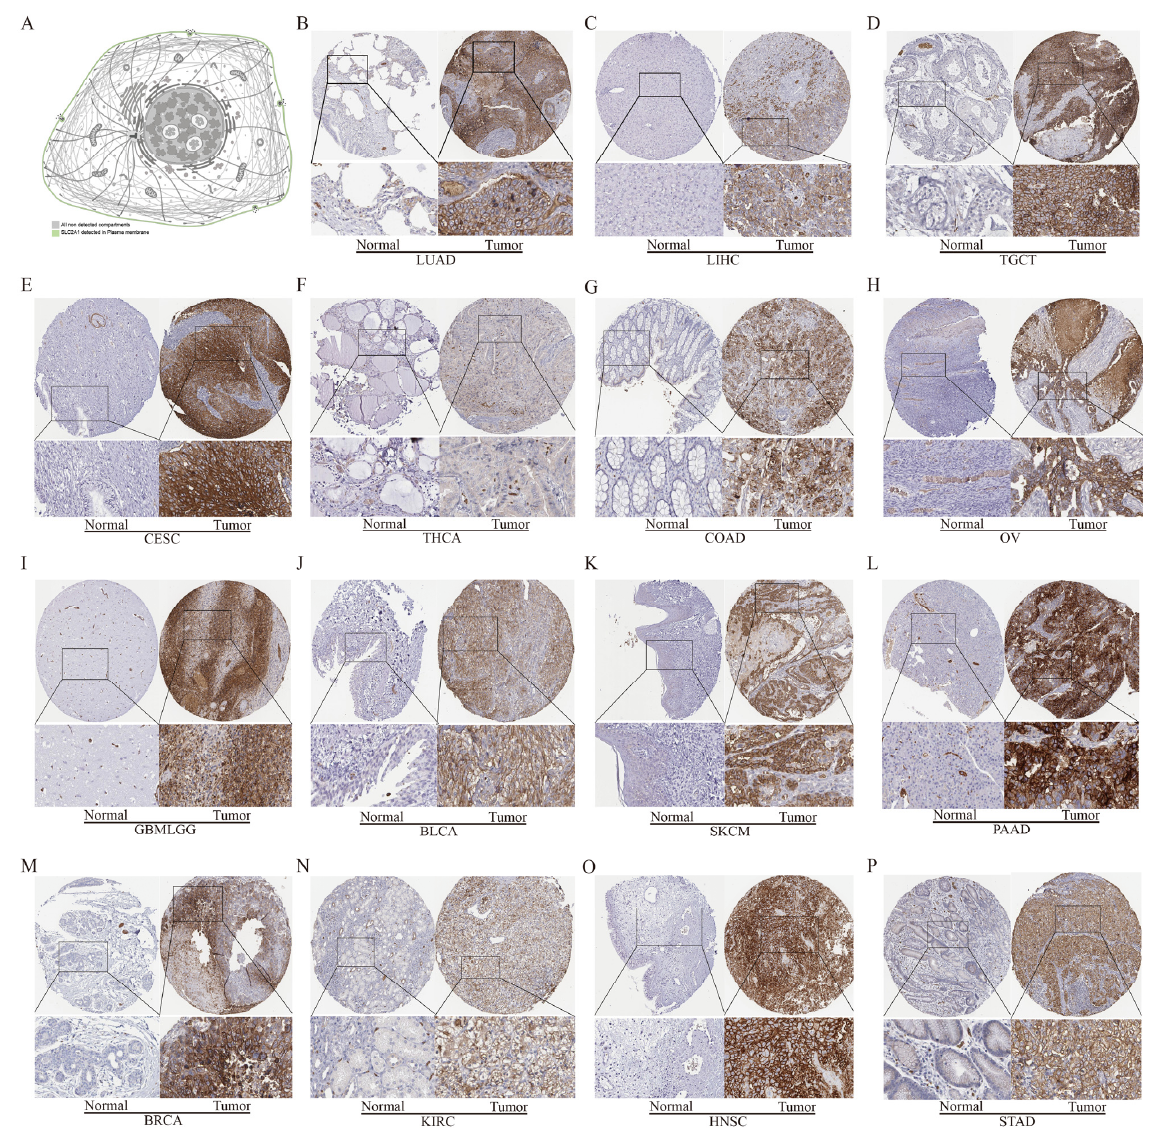
Figure 4. Protein level analysis of SLC2A1 in pan-cancer. Subcellular localization of SLC2A1 in cancer cells per the HPA database ( A ); immunohistochemical data of SLC2A1 in pan-cancer from HPA dataset ( B – P ).